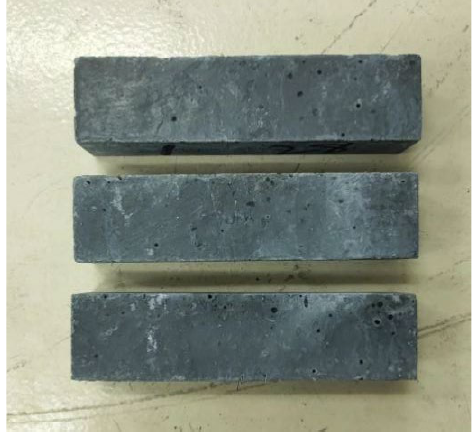
Figure 4. Prism samples for flexural strength tests.